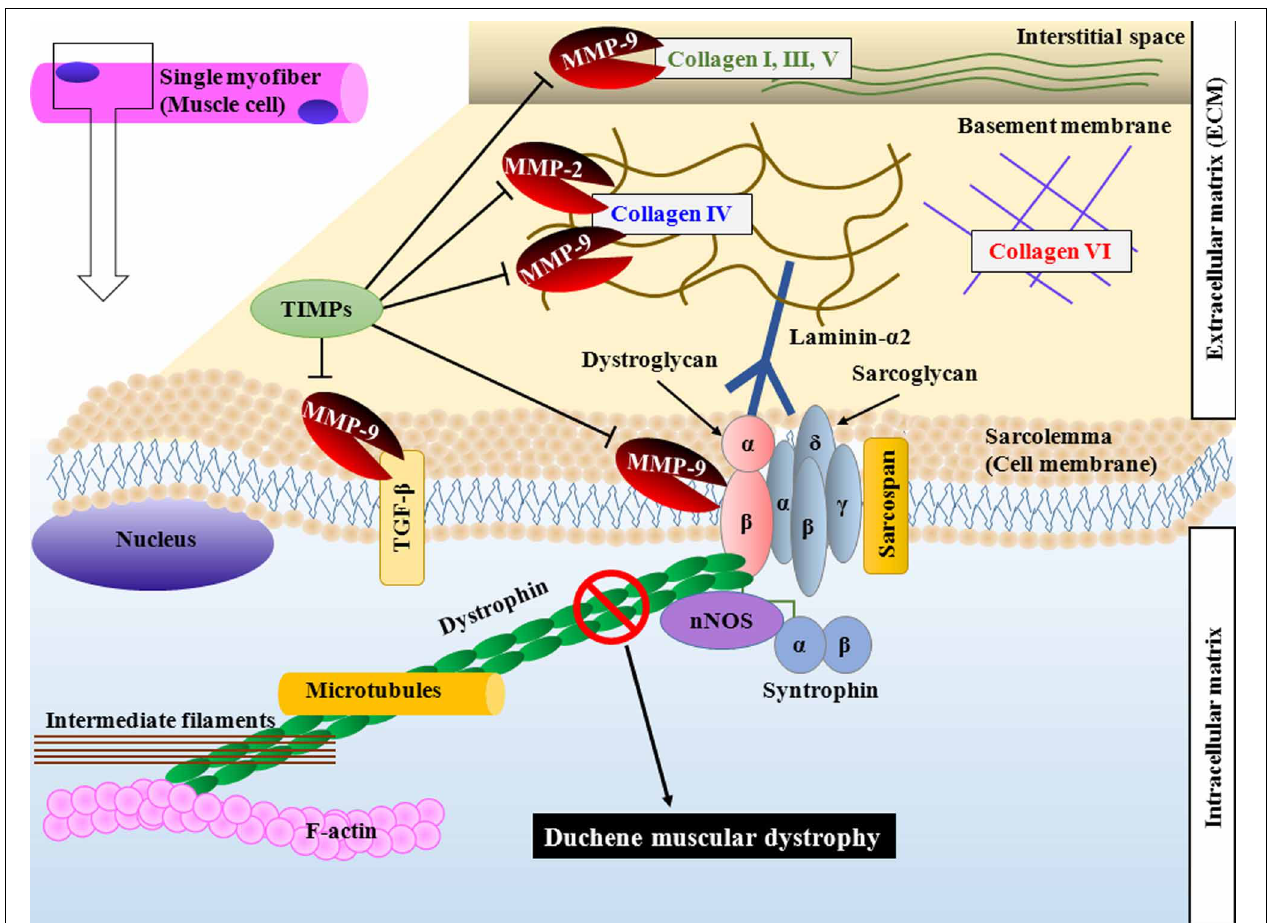
FIGURE 1 | Schematic representation of DGC and components of ECM targeted by MMPs in skeletal muscle. Dystrophin stabilizes muscle cells by linking F-actin, intermediate filaments and microtubules to transmembrane DGC and ECM. Loss of dystrophin causes sarcolemma instability and increases susceptibility of sarcolemma to mechanical stress. MMPs are secreted by several cell types in skeletal muscle and cause proteolysis of specific substrates. MMP-2 and MMP-9 degrade collagen type IV. MMP-9